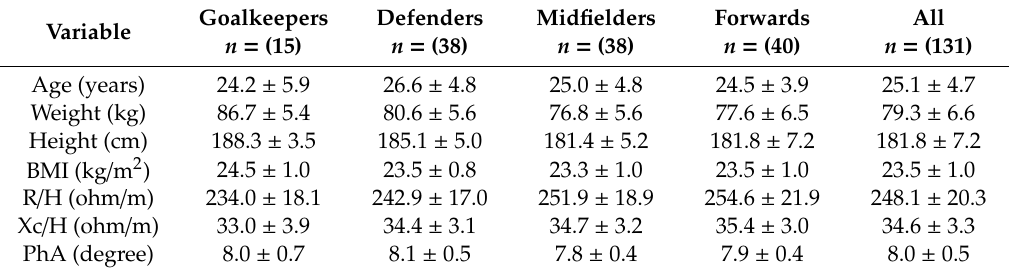
Table 1. Descriptive statistics for the soccer players according to playing